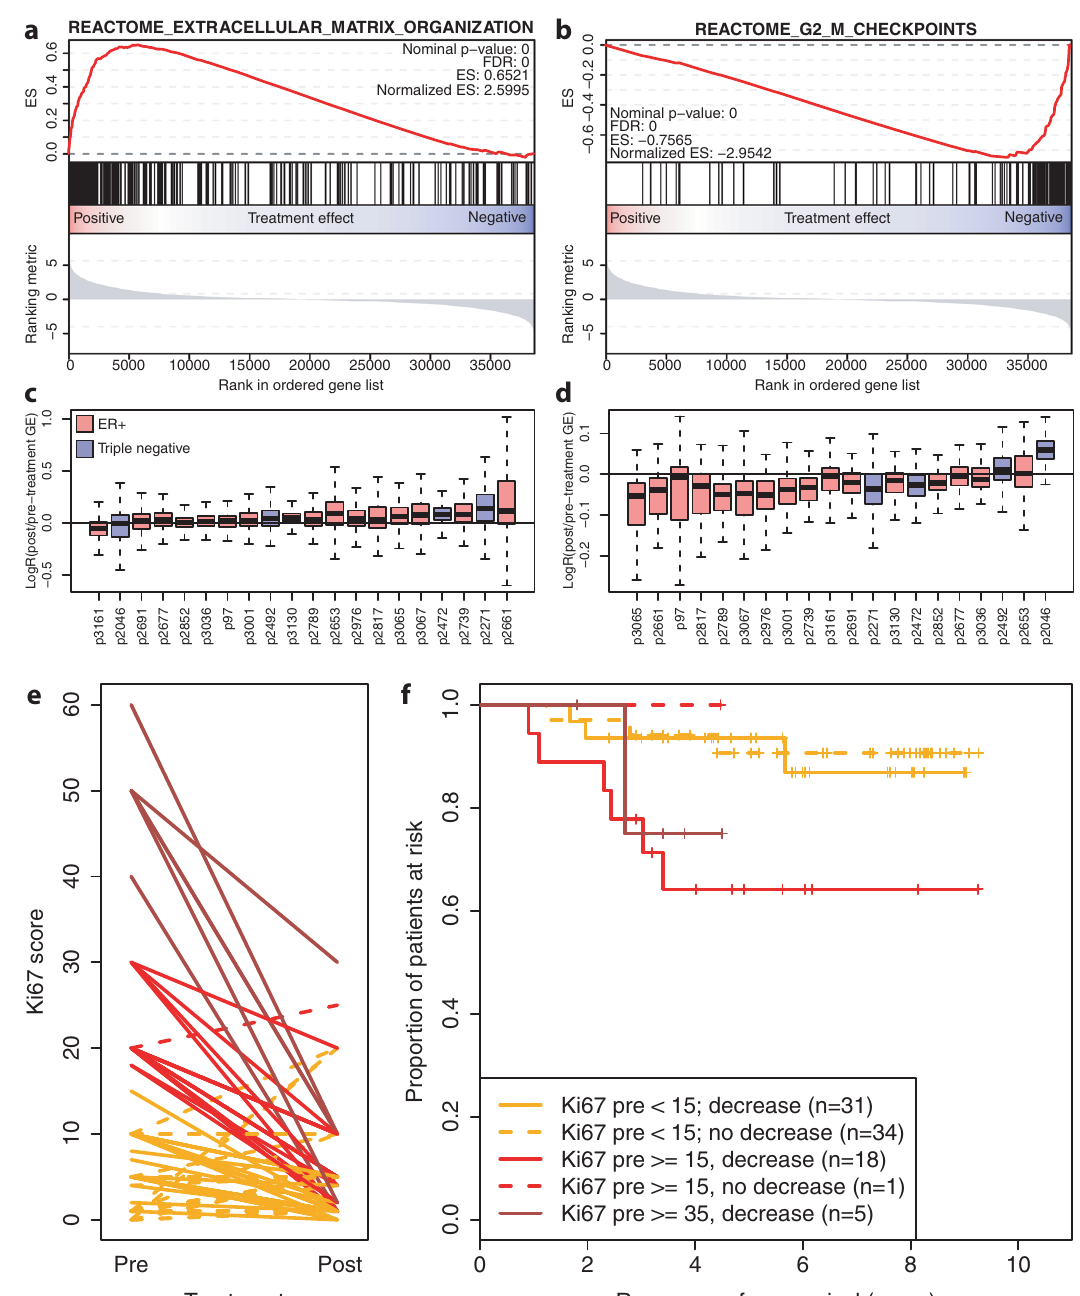
Fig. 2 Transcriptomic differences between breast tumors before and after chemotherapy. a Gene set enrichment plot of genes involved in extracellular matrix organization according to the reactome database. Genes are ordered based on the differential gene expression analyses: genes on the right side of the plot are down-regulated upon treatment, whereas genes on the left are upregulated. FDR: False Discovery Rate, ES enrichment score. b Gene set enrichment plot of genes involved in the G-phase to M-phase checkpoint according to the reactome database. Layout is identical to ( a ). c Boxplots of log fold changes between pre- and post-treatment samples of the geneset shown in ( a ). Every box is one sample: red are ER + samples, blue are triple negative. The box indicates the interquartile range, while lower and upper bars correspond to the minimum and maximum non-outlier values of the data distribution. Outliers are de fi ned as values outside 1.5× the interquartile range from the box. The center line indicates the median value. d Boxplots of log fold changes between pre- and post-treatment samples of the geneset shown in ( b ). Every box is one sample: red boxes are ER + samples, blue boxes are triple negative. Boxplots are constructed in the same manner as in ( c ). e Interaction plot showing the effect of chemotherapy on proliferation in ER + samples, measured the percentage of cells positive for Ki67. In red are samples with a relatively high proliferation rate before treatment (Ki67 ≥ 15), in orange are samples with a low pre-treatment proliferation rate (Ki67 < 15). f Kaplan – Meier curves of the samples shown in ( e